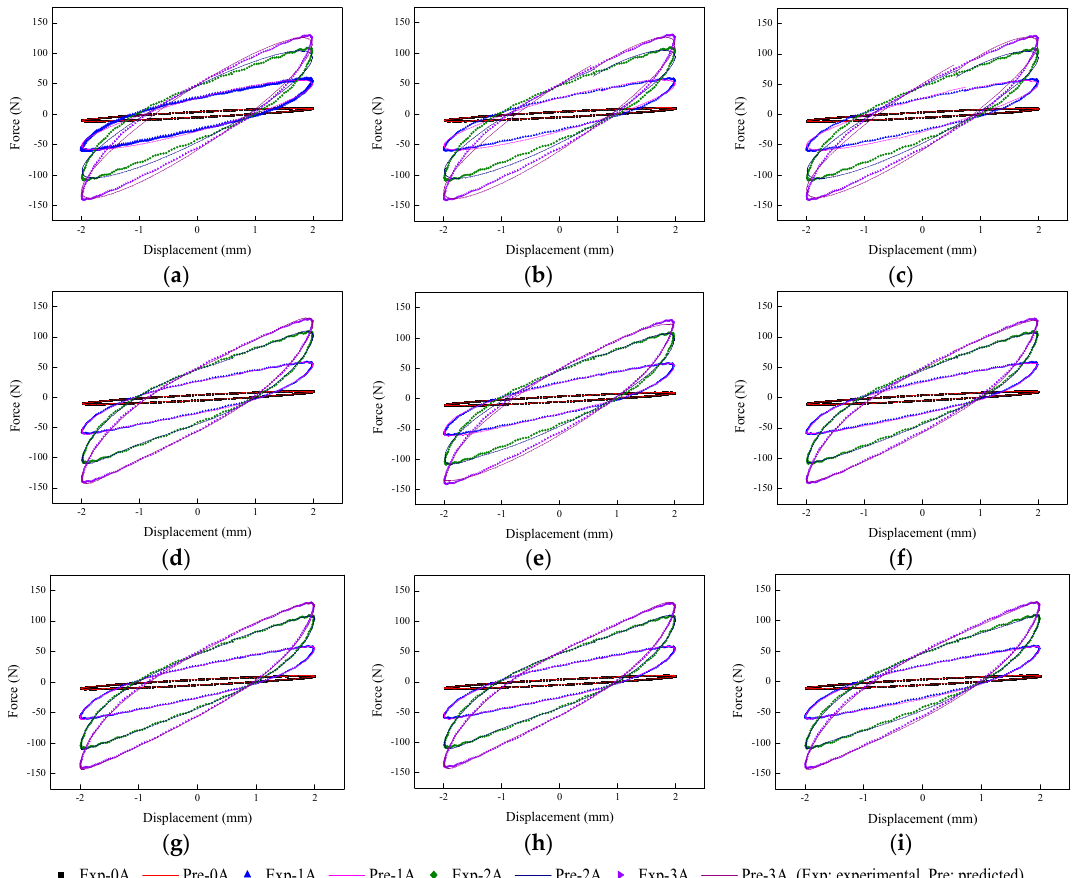
Figure 18. Comparisons of force–displacement responses between experimental results and model predictions when the loading frequency and amplitude are 1 Hz and 2 mm. ( a ) Kelvin–Voigt model, ( b ) four-parameter viscoelastic model, ( c ) rheological model, ( d ) BW model, ( e ) improved BW model, ( f ) Dahl model, ( g ) improved LuGre friction model, ( h ) strain stiffening model, and ( i ) hyperbolic hysteresis model.